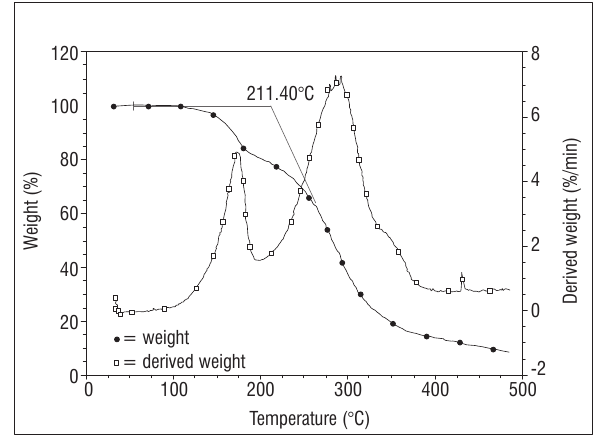
Figure 4: Typical thermogram for croton oil methyl ester.